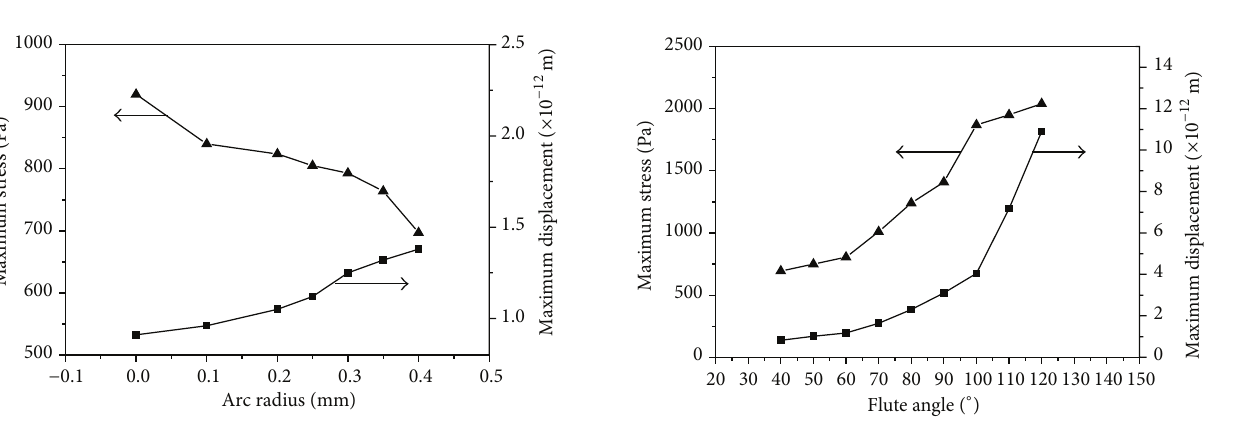
Figure 12: Maximum stresses and maximum displacements of corrugated board models with different flute angle 𝜃 .